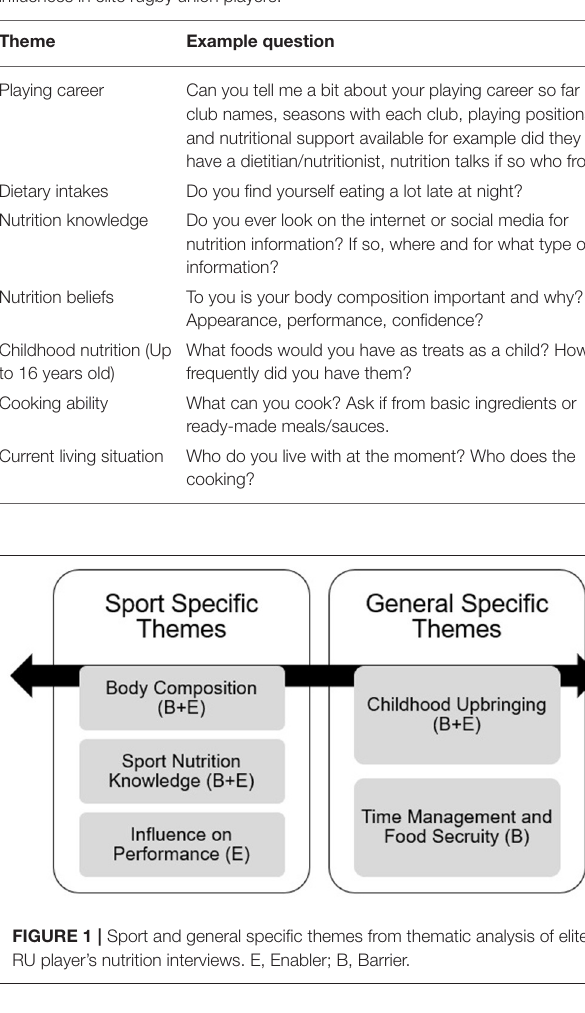
TABLE 2 | Interview themes used to promote discussions about nutritional influences in elite rugby union players.